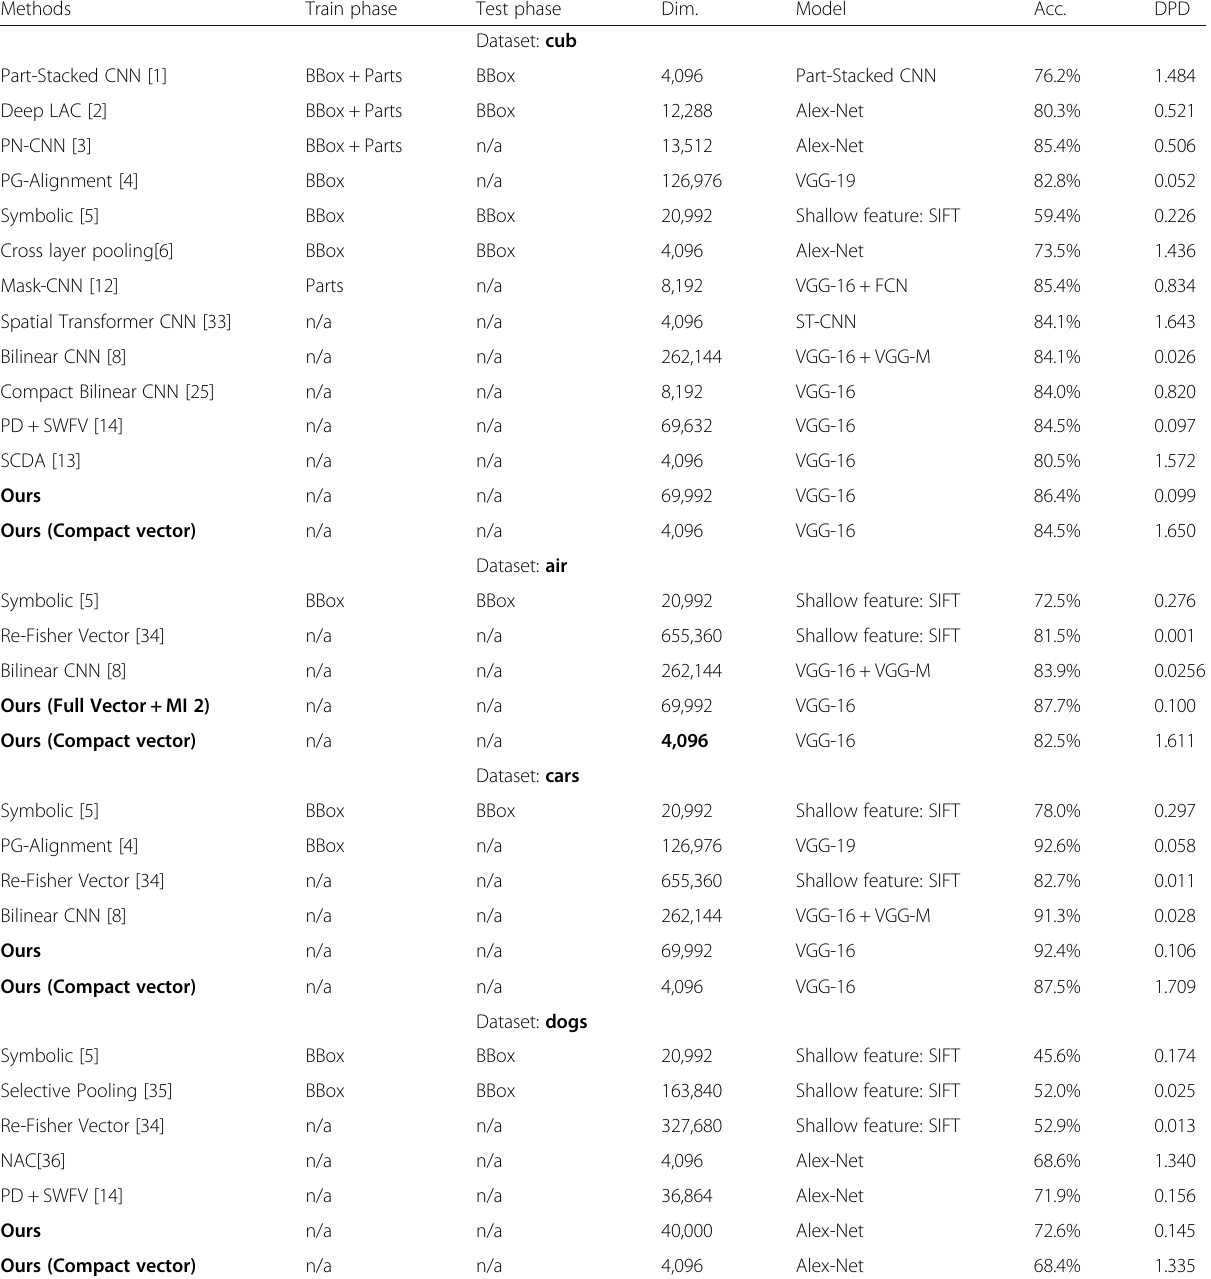
Table 5 Comparison of performance of our methods with some recent state-of-the-arts methods in cub. BBox, Parts denote bounding-box and parts annotation